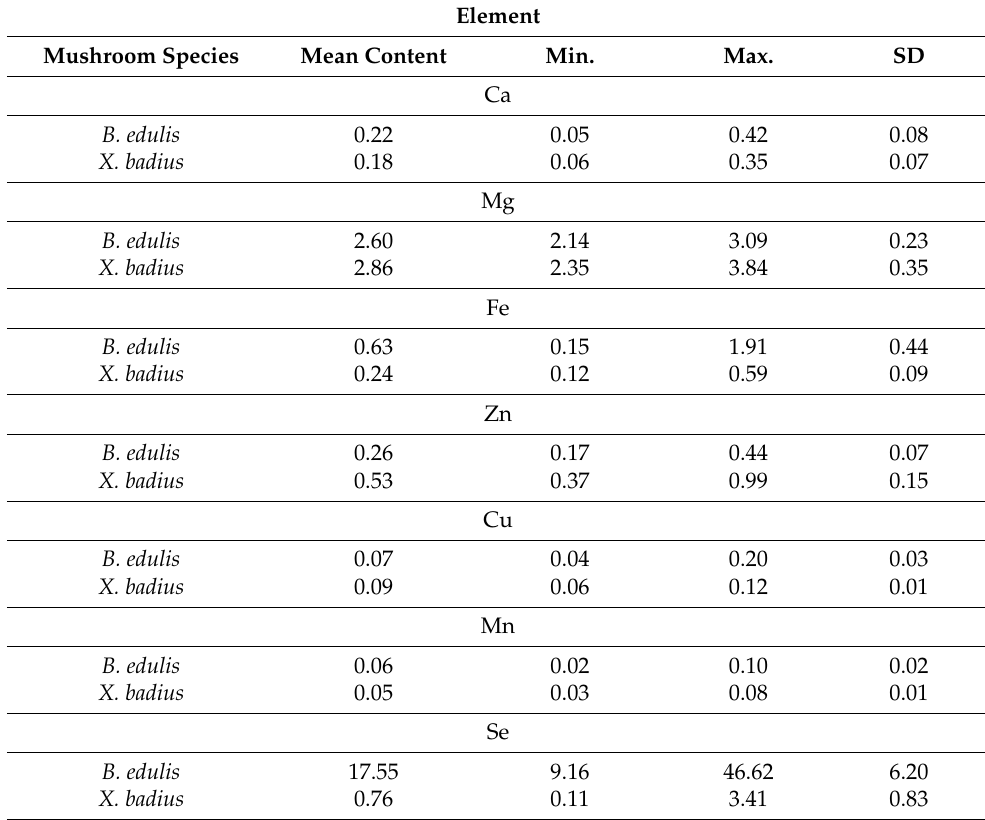
Table 5. Content of Ca, Mg, Fe, Zn, Cu, Mn (mg/kg), and Se ( µ g/kg) in a standard portion (2.7 g) of dried